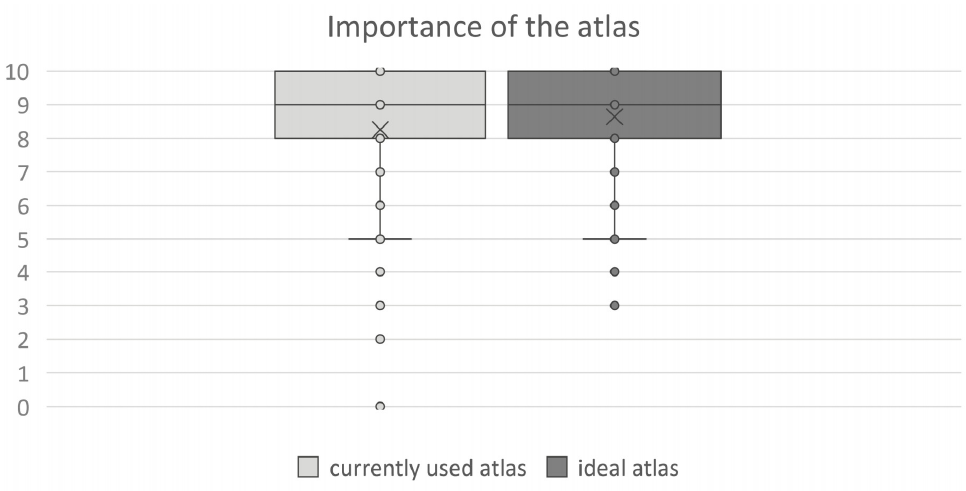
Figure 2. Summary of Q1 and Q24 evaluating the importance of the currently used atlas ( left ) and the teacher’s notions of an ideal atlas ( right ).